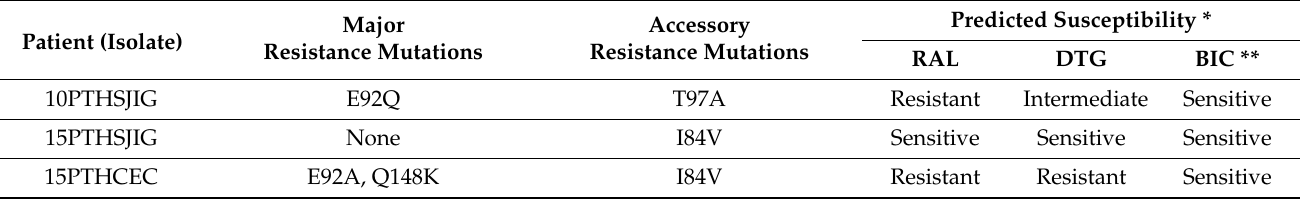
Table 3. Resistance mutations in the integrase protein of RAL-experienced patients and susceptibility to RAL and